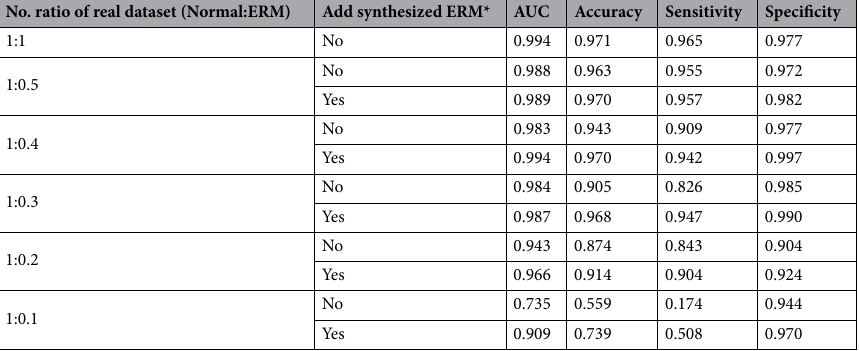
Table 4. Classification performance for various ratios between normal and ERM. AUC, accuracy, sensitivity, and specificity were shown for each ratio with and without adding synthesized ERM images. * Yes means adding synthesized ERM for balancing number ratio with normal